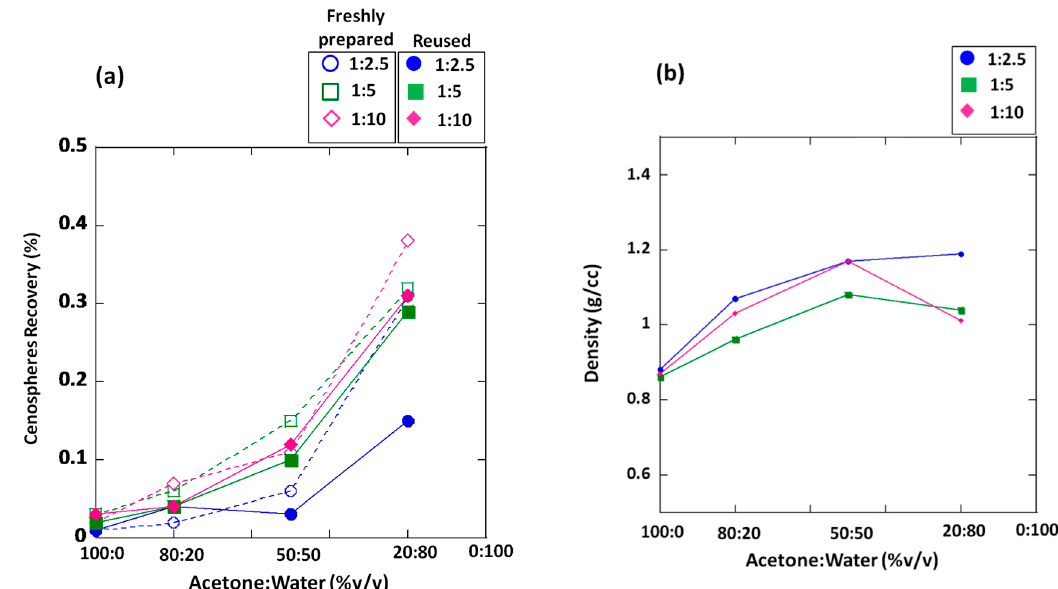
Figure 1. Plots of accumulative percentages of cenosphere recovery against ( a ) the ratio of the acetone–water mixture, comparing the results obtained from the freshly prepared and the reused mixtures, and ( b ) the density of the cenosphere fractions obtained from using the freshly prepared mixtures. All data points were obtained from five measurements, and the SD of all points shown in ( b ) is less than 0.005. Due to the small SD values demonstrated in Table 1 and in the results in Figure 1b, the error bars for the data in Figure 1a,b are fairly invisible. Cenospheres were collected from using different ratios of acetone–water mixtures, a 4-h soaking period, and fly ash/medium ratios of 1:2.5, 1:5, and 1:10.